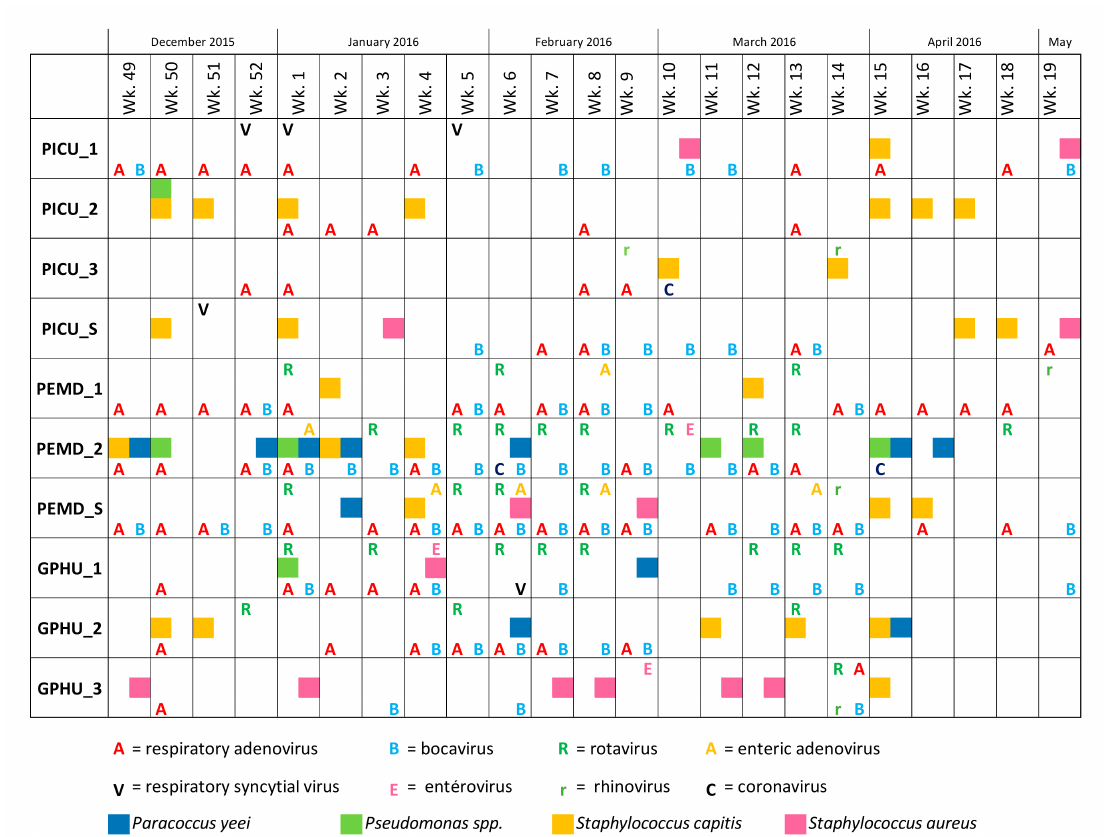
Figure 1. Overview of the contamination of the mobile phones (MPs) used by the paediatricians working in University Hospital of Saint-Etienne for 23 weeks. The names of the MPs are explained in the legend of Table 1. wk: